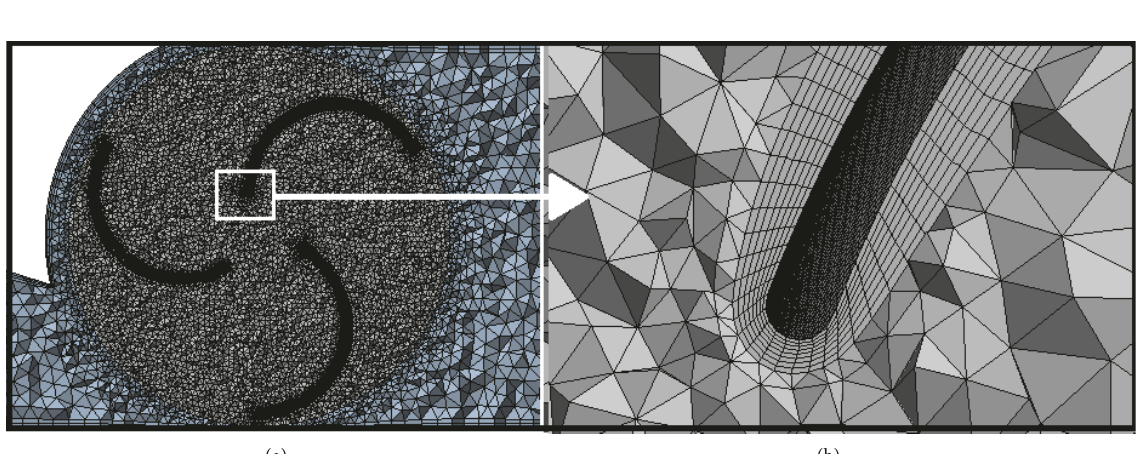
Figure 6: Generated Grid: (a) around the 3-bladed turbine and (b) prism layer around the